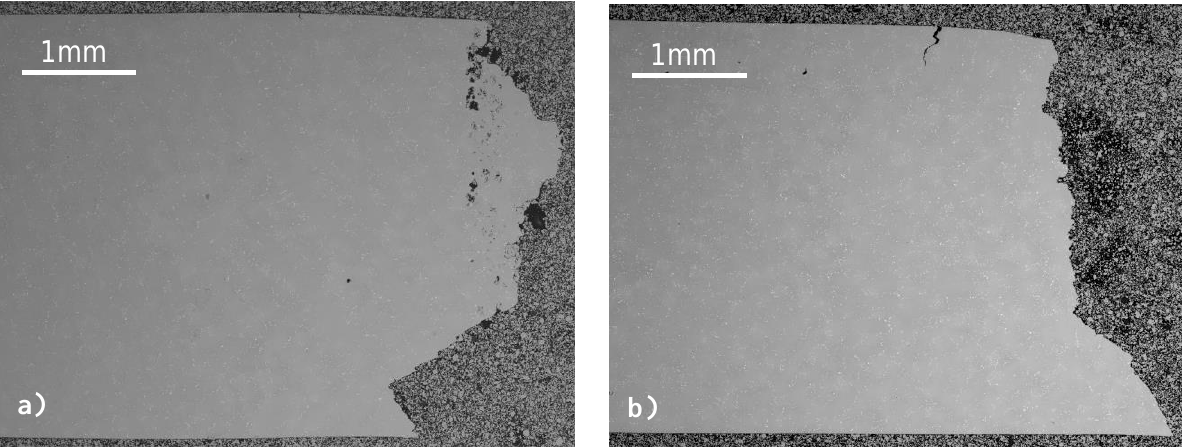
Figure 8: Fracture longitudinal cross-sections of creep specimen of superalloy MAR-M247 (G variant) loaded by stress 400 MPa at tempera- tures a) 800 ∘ C and b) 950 ∘